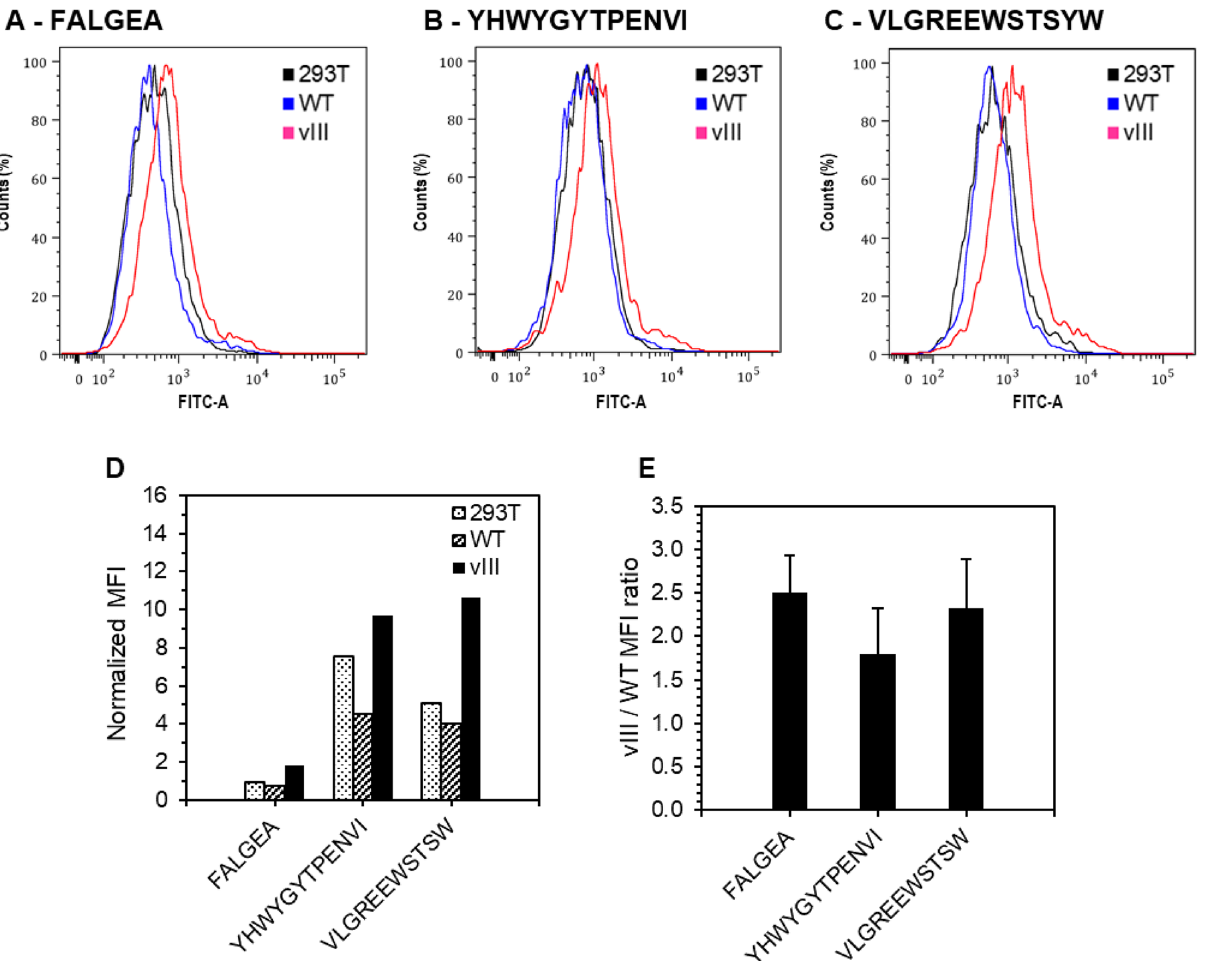
Figure 4. Quantitative cellular binding of FITC-Ahx-peptides on 293T, WT and vIII cells by flow cytometry. ( A–C ) 293T cells (black), EGFR WT cells (blue) and EGFRvIII cells (red) were incubated with 10 µM of FITC-Ahx-peptides: ( A ) FALGEA, ( B ) YHWYGYTPENVI, ( C ) VLGREEWSTSYW for 20 min at RT. ( A–C ) Cell counts in % versus FITC signal. ( D ) Normalized mean fluorescence intensities (MFI) of each peptide for each cell line. ( E ) Ratio (mean and standard deviation) for each peptide of the normalized MFI obtained for EGFRvIII cell line over EGFR WT cell line at 3 different concentrations 1 µM, 5 µM and 10 µM.